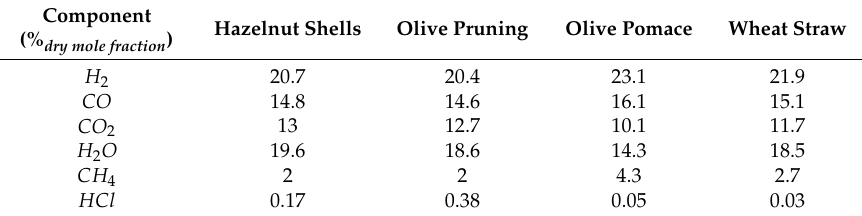
Table 8. Composition of the syngas in %dry mole fraction.